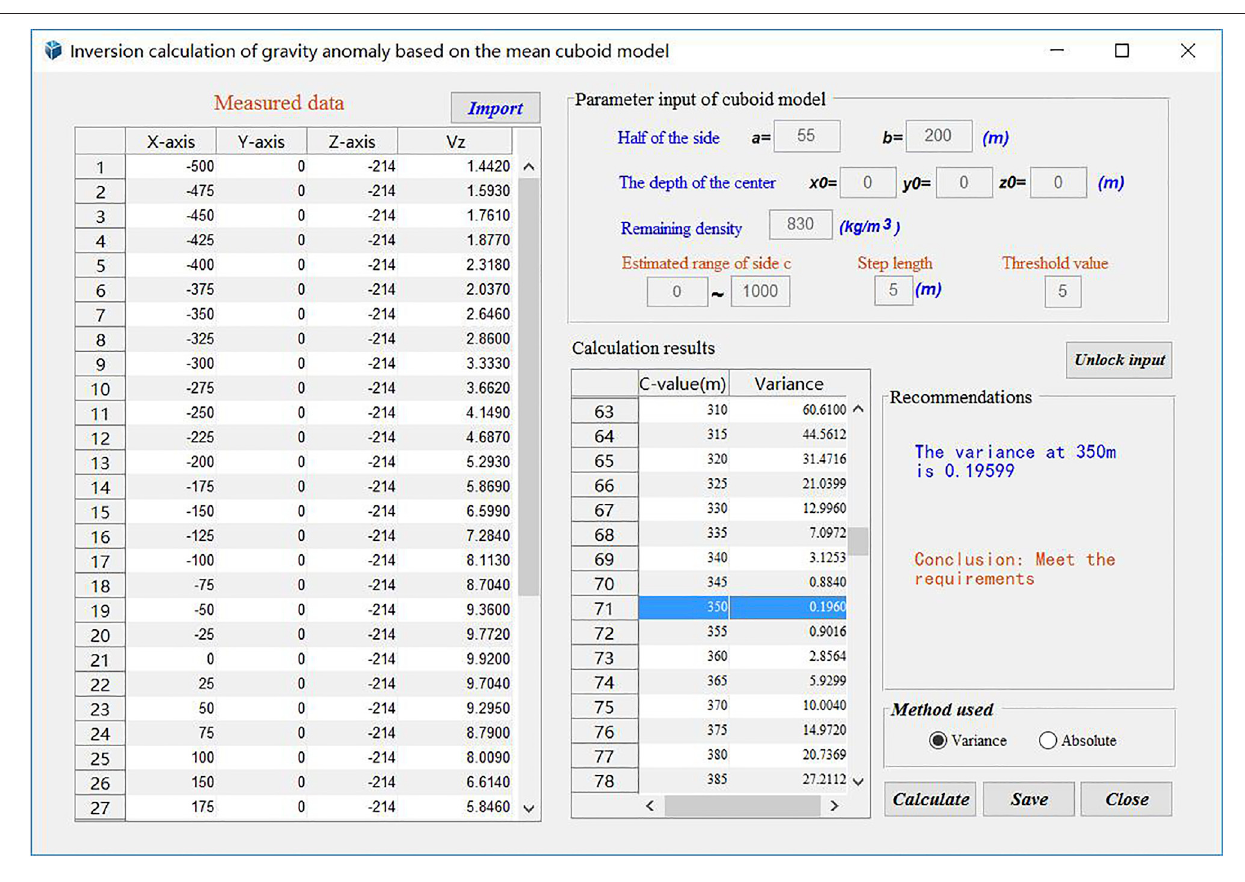
FIGURE 10 | Screenshot of the results of the fl at method inversion